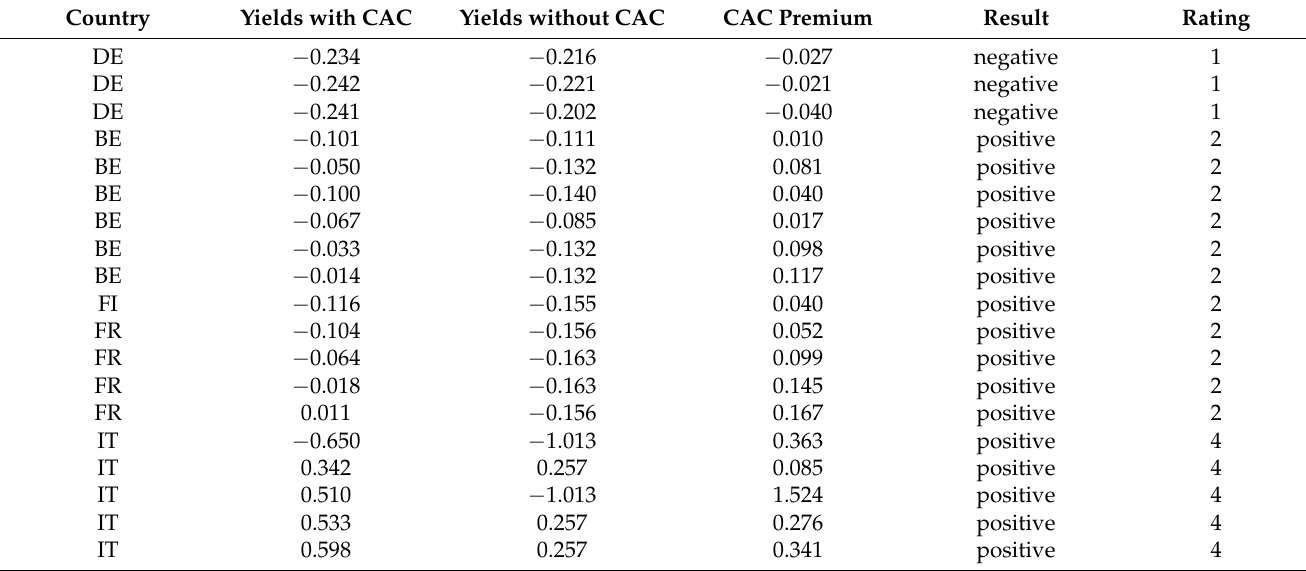
Table A2. CAC premium for five-year sovereign bonds (Source: Authors).